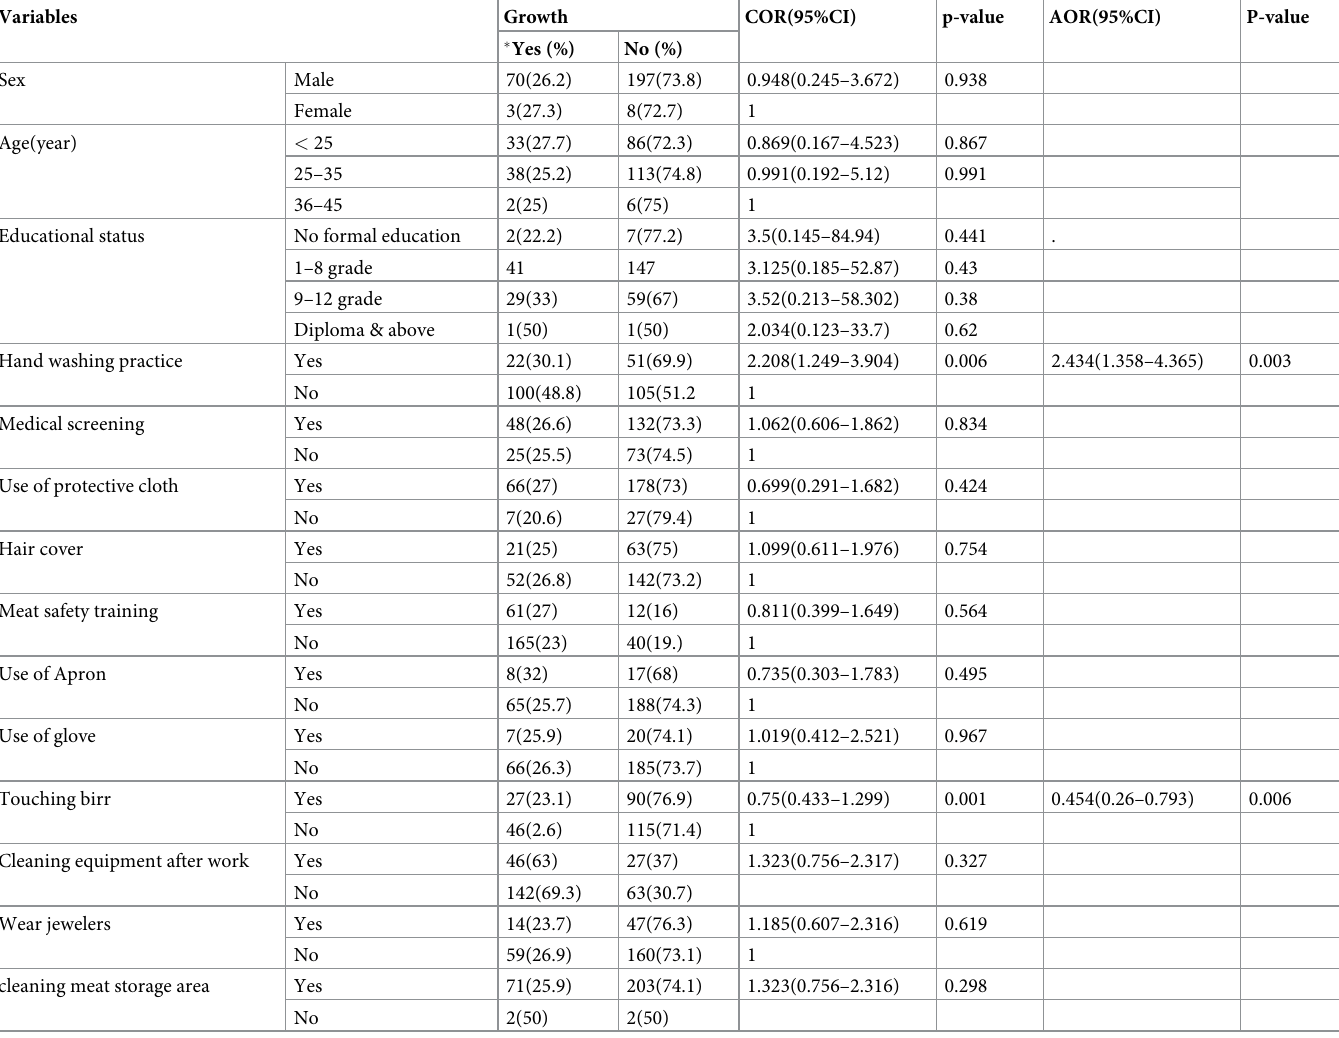
Table 3. Bivariate and multivariate analysis of factors associated with the prevalence of Salmonella species and ESBL producing E . coli from raw meat and swab sam- ples collected from butcher shops at Hawassa city, Sidama regional state, Ethiopia, 2020 (n = 556).